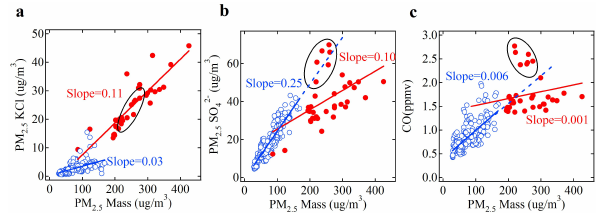
Fig. 5. Scatterplots of (a) KCl, (b) sulfate and (c) CO vs. PM 2 . 5 mass concentration separately for the pollution episode (red) and for the non-episode (blue) days between 7 and 15 June 2012. Note: black ellipses mark the data for a period of 12:00–17:00LT, 10